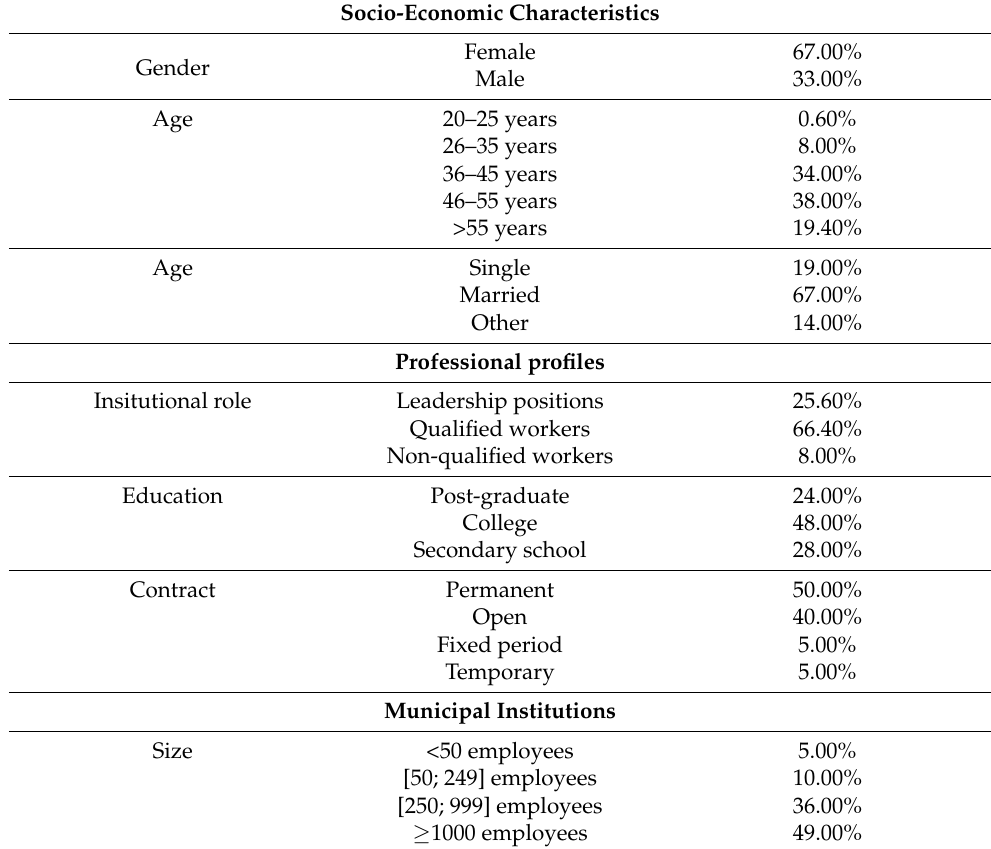
Table 1. Socio-economic characteristics, professional profiles, and the size of the institutions of the municipal